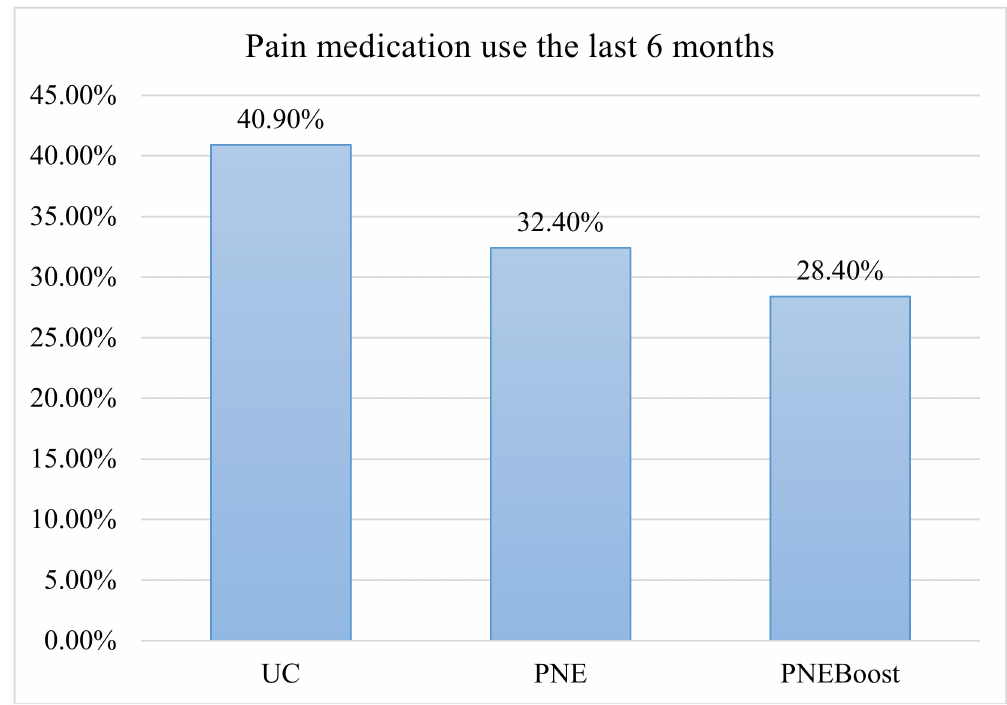
Figure 2. Self-reported use of pain medication in the 6-month period following initial